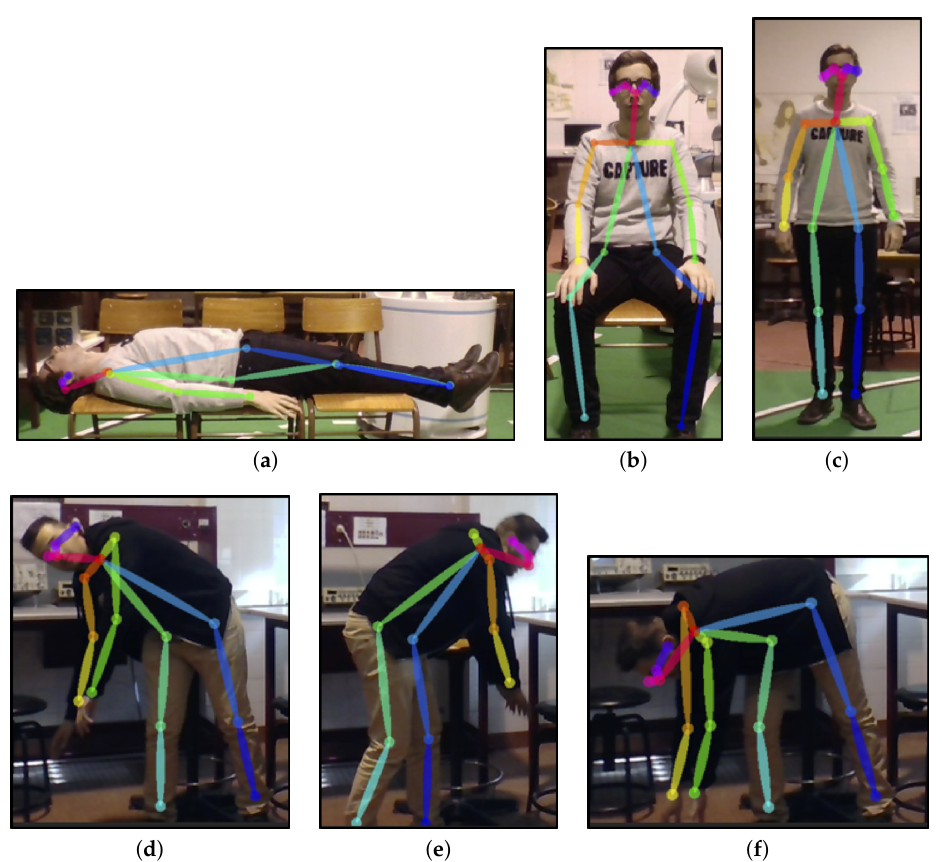
Figure 6. This figure shows examples of all the human poses classes, used in this work: ( a ) Lying down; ( b ) Sitting; ( c ) Standing; ( d ) Slanted Right; ( e ) Slanted Left; ( f )